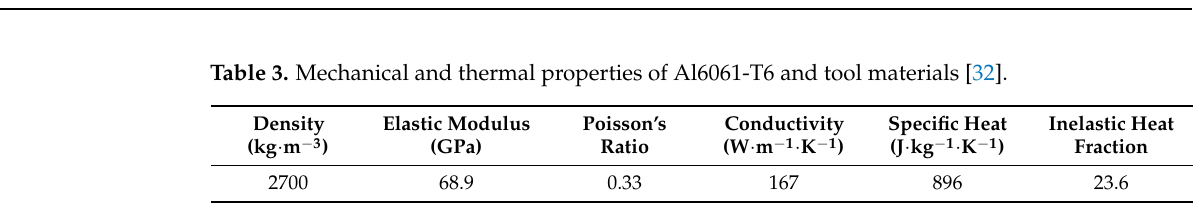
Table 3. Mechanical and thermal properties of Al6061-T6 and tool materials [32].